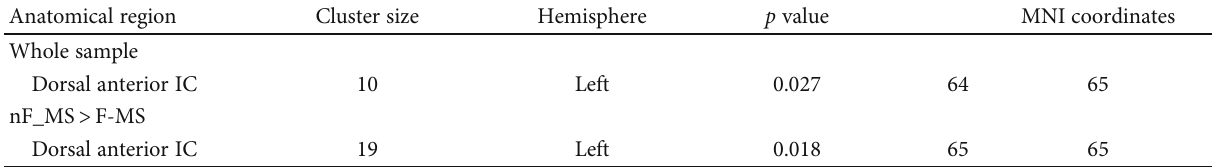
Table 2: Decreased areas of GM volume in the whole group and in the F-MS group. Values are FWE corrected. Anatomical region